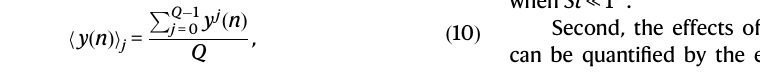
x 3 =2.5m. Typically, when ∣ ζ ∣≲ 0 : 1, the ASL at height x 3 is considered near-neutral 46,55 .